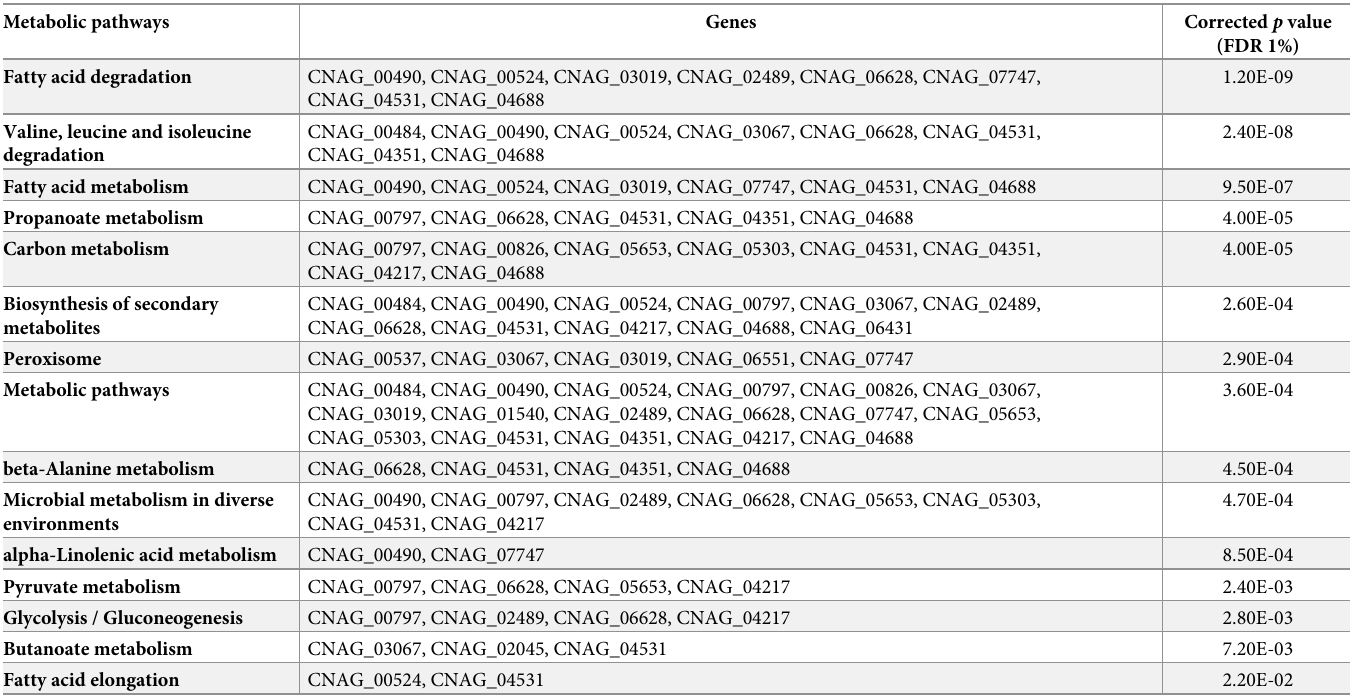
Table 2. Metabolic pathways regulated in VBNC by STRING